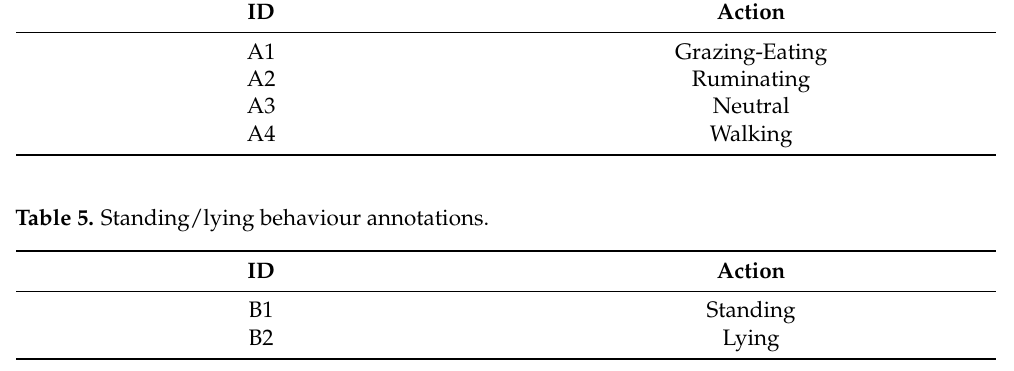
Table 5. Standing/lying behaviour annotations.